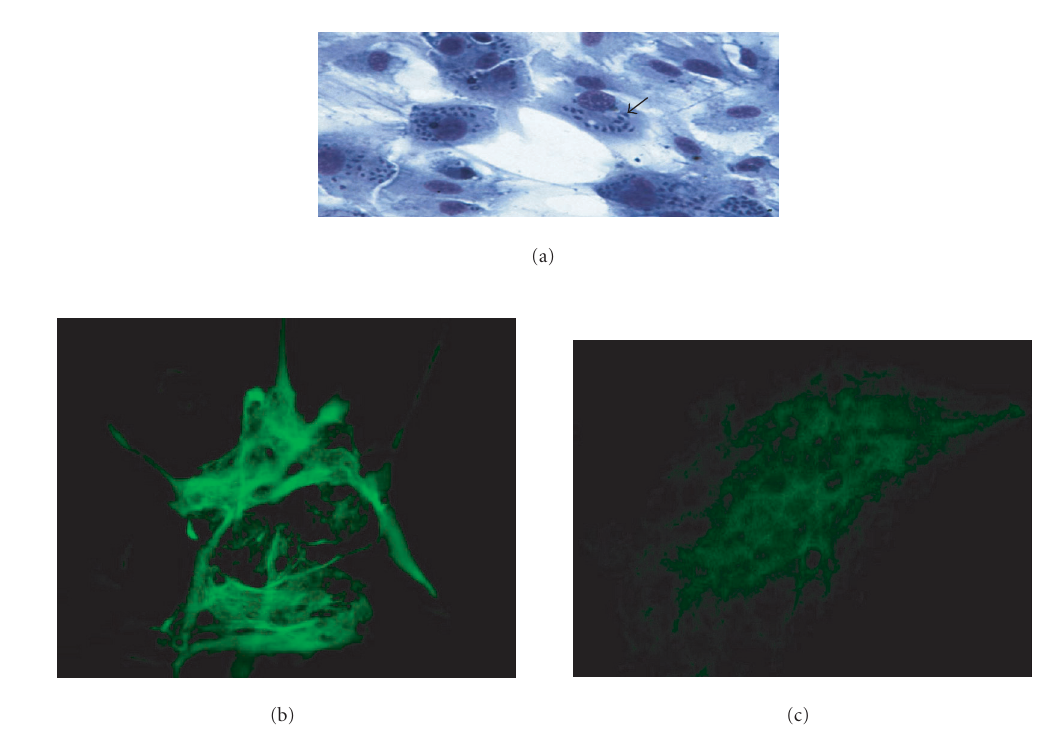
Figure 1. (a) Light microscopy examination of astrocytes infected in vitro by Trypanosoma cruzi trypomastigotes showing high- density intracellular replicating amastigotes (arrow). (b) and (c) E ff ect of trypomastigotes upon immunologically detectable glial fibrillary acidic protein (GFAP) of living rat astrocytes. Briefly, primary cultures astrocytes were made from newborn rat cerebral cortex. After the meninges had been cleaned o ff , the brain tissue was forced gently through a nylon sieve. Dulbecco’s modified Eagle medium supplemented with 10% calf serum, 2 mM glutamine, 50 µ g/mL gentamycin was used for the dissociation of cerebral tissue and development of astrocytes. Aliquots (0.2mL) of cell suspension containing 2 × 10 4 cells were placed in 24-well microplates; each well contained a glass coverslip (12mm diameter). The cells were allowed to attach to the solid phase, and then viable trypomastigotes were added in culture medium at 10 5 parasites per well. After 3hours at 37 ◦ C, each well was emptied and washed twice to remove free-swimming parasites. The cells were fixed in 0.1% paraformaldehyde in PBS at 4 ◦ C during 20 minutes and washed with PBS. They were then incubated for 1hour at room temperature in PBS containing 1% triton × 100 and 1% bovine serum albumin (BSA). After three washes in PBS, the cells were treated with fluorescein-conjugated rabbit anti-GFAP antibodies diluted 1 : 100 in PBS-BSA. After three washes in PBS, the cells were counterstained with 0.02% Evans blue in PBS and, in order to reduce fading, mounted in Citifluor AF1 (glycerol: PBS solution (9/1), Citifluor Ltd, London,UK). (b) Fluorescence micrograph of astrocytes incubated with culture medium alone and reacted with anti-GFAP antibodies showing normal distribution of GFAP. (c) Cell distribution of GFAP network after infection with